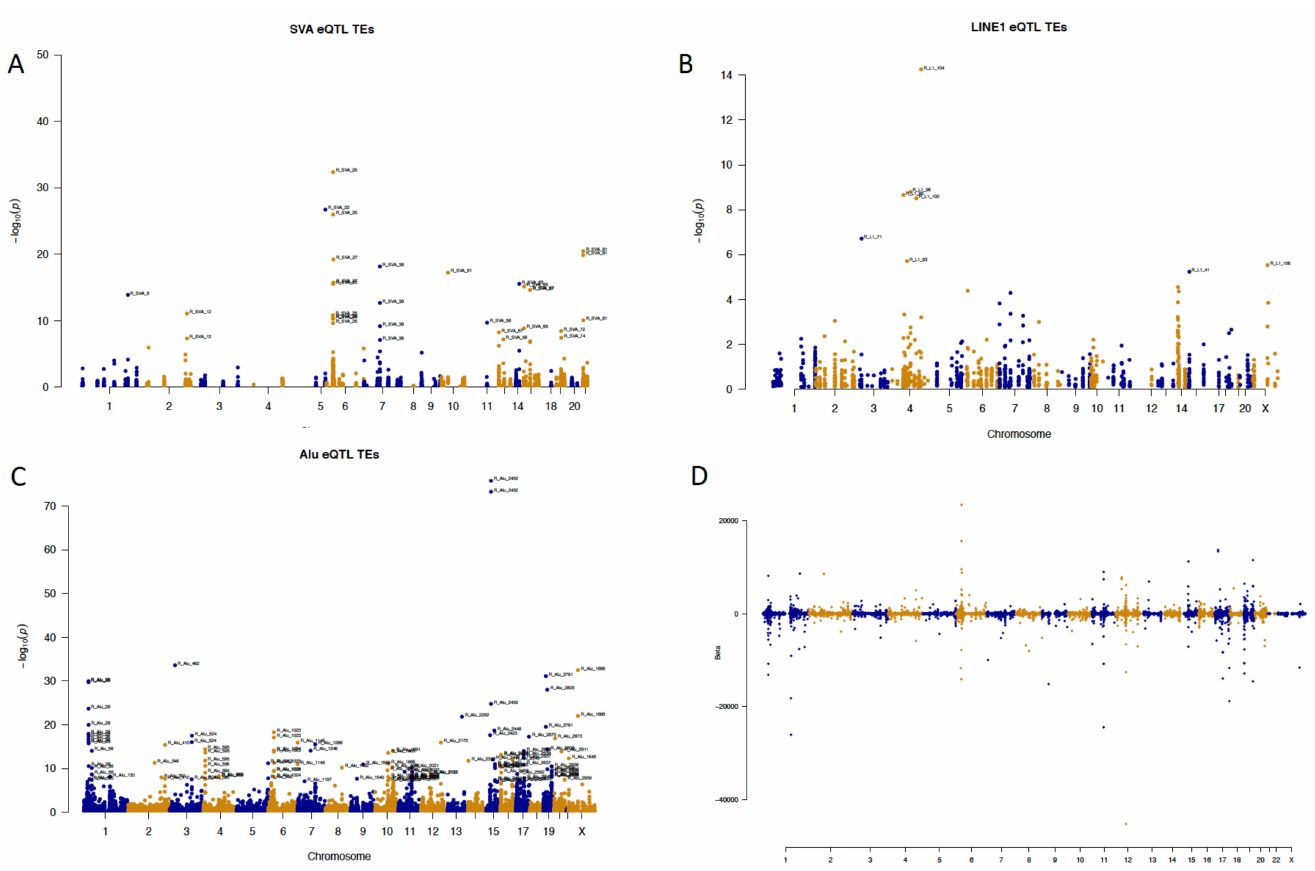
Figure 2. ( A – C ) Manhattan plots of SVA, L1 and Alu repeats illustrating the FDR values and locations of the target genes. ( D ) Manhattan plot showing effect sizes (beta values) of all TEs and the locations of their respective target